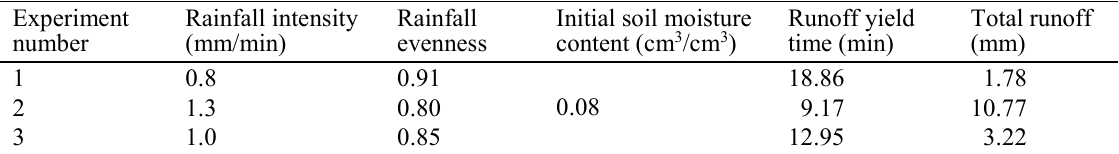
Table 1 Rainfall infiltration, and runoff cases in runoff plots under different intensity. Experiment number